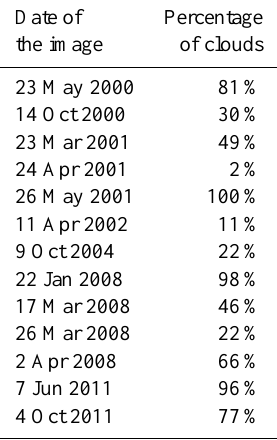
Table 2. Acquisition dates of the ASTER images used to assess the quality of the different cloud masks.